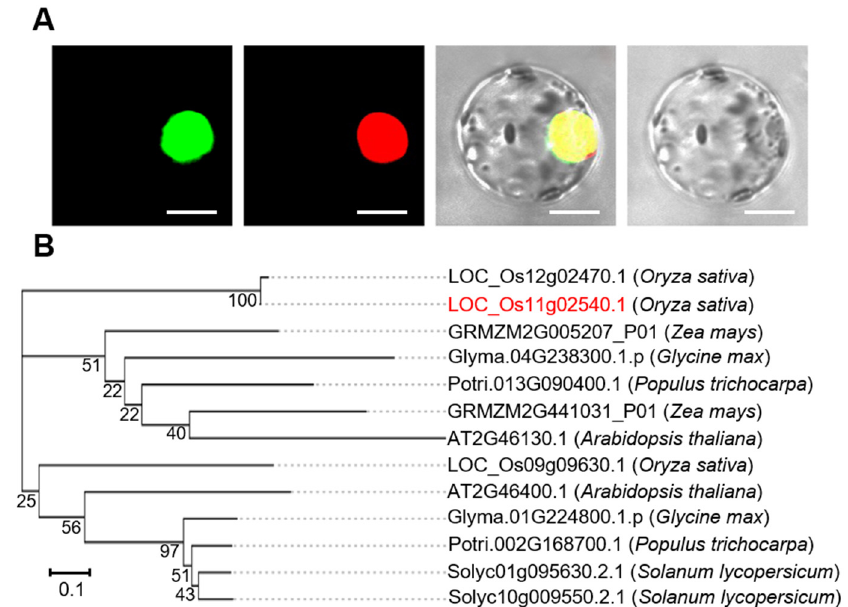
Figure 2. Subcellular localization and phylogenetic analysis of OsWRKY50. ( A ) Subcellular localization of OsWRKY50. The plasmid OsWRKY50 -GFP was transformed into rice protoplasts together with NLS ‐ RFP (nuclear localization signal fused with red fluorescent protein) and observed under a florescence microscope. The bars represent 10 μ m. ( B ) Phylogenetic tree based on amino acid from each of the plant species. The phylogenetic tree was constructed by utilizing the MEGA5 Neighbor Joining algorithm based on conserved amino acid sequences calculated using the bootstrap method. Bootstrapping with 1000 replicates were shown at each node.